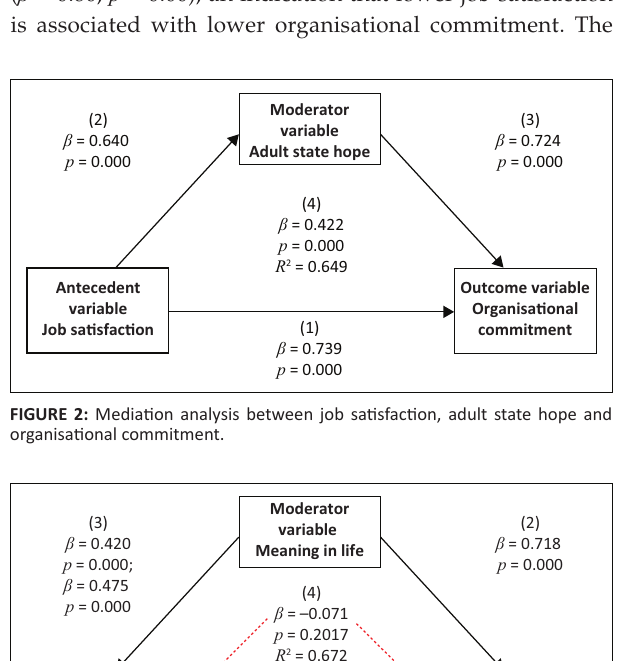
organisational commitment. The results are reported in Figure 2.